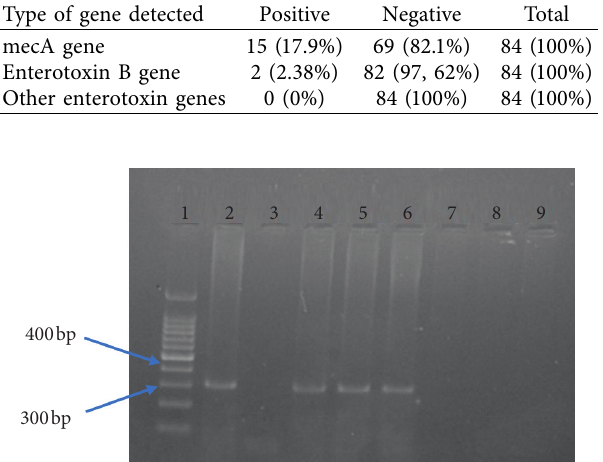
Figure 2: PCR amplification of mecA gene of S . aureus on 2% agarose gel electrophoresis. Lane 1 DNA ladder, MW 100–1500bp fragments. Lanes 2, 4, 5, and 6 show a typical band size of 310bp corresponding to mecA gene products of S . aureus isolated from samples number 13, 55, 63, and 81. Lanes 3, 7, 8, and 9 are the negative samples.